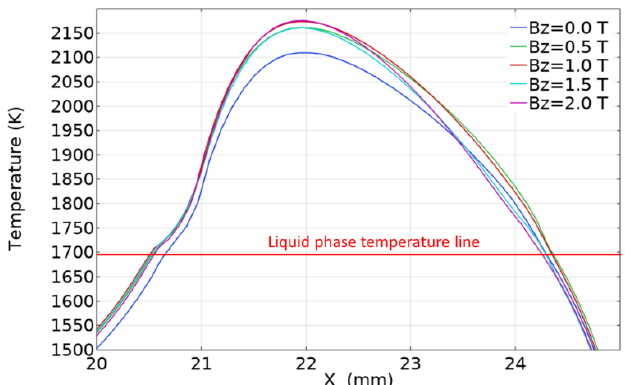
Figure 4. Temperature field distribution on the melting surface at different magnetic flux densities (t = 4.5 s).